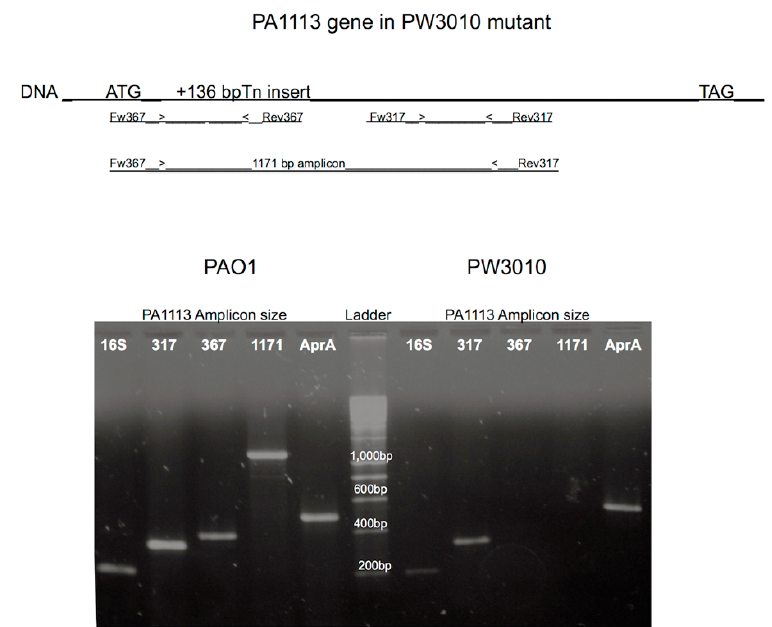
Figure 3. Expression of the PA1113 gene in PAO1 and its mutant PW3010. ( Top ) Schematic Figure3. ExpressionofthePA1113geneinPAO1anditsmutantPW3010. ( Top )Schematicrepresentation representation of the PA1113 gene. +136 bp after the ATG, shows the insertion position of the of the PA1113 gene. + 136 bp after the ATG, shows the insertion position of the transposon (ISlacZ / hah). transposon (ISlacZ/hah). Below are the amplicons that were synthesized by RT-PCR to check the Below are the amplicons that were synthesized by RT-PCR to check the expression of the gene. expression of the gene. ( Bottom ) The results generated by PCR from cDNAs obtained after reverse ( Bottom ) The results generated by PCR from cDNAs obtained after reverse transcription on the total transcription on the total RNAs of PAO1 (on the left) and its mutant (on the right). RT-PCR was RNAs of PAO1 (on the left) and its mutant (on the right). RT-PCR was performed on total RNAs as performed on total RNAs as described in the Materials and Methods section. described in the Materials and Methods